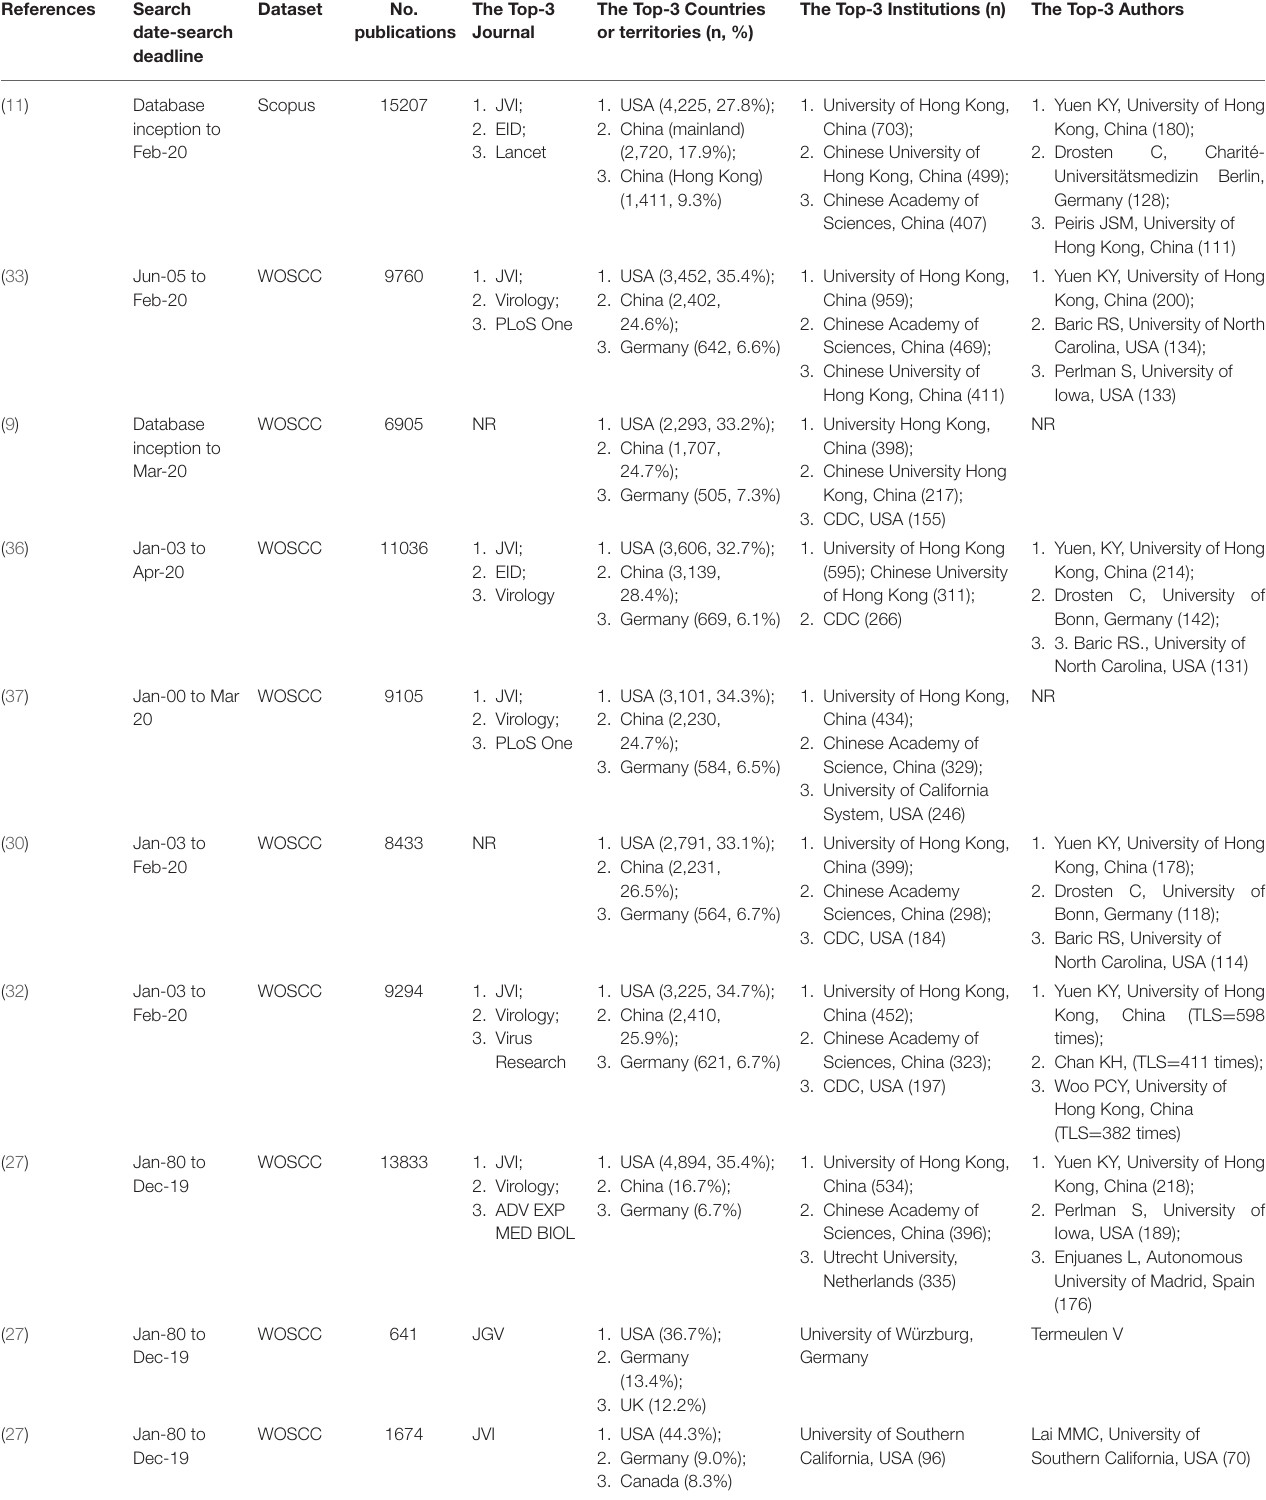
TABLE 4 | The characteristics and top-3 information of published bibliometric